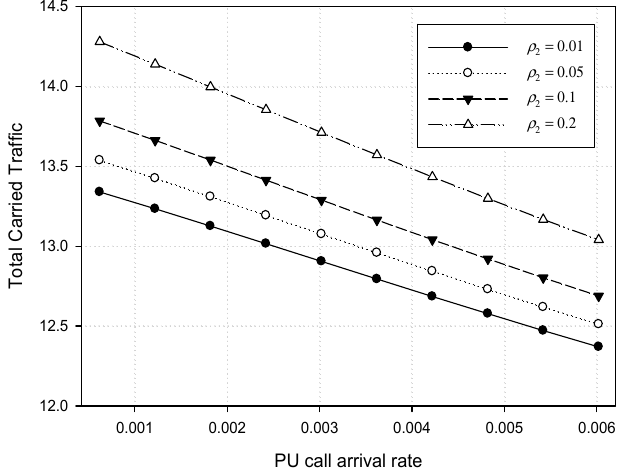
Figure 8. Total carried traffic for both PU and CU calls.